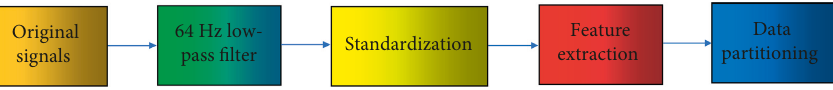
Figure 5: Data preprocessing